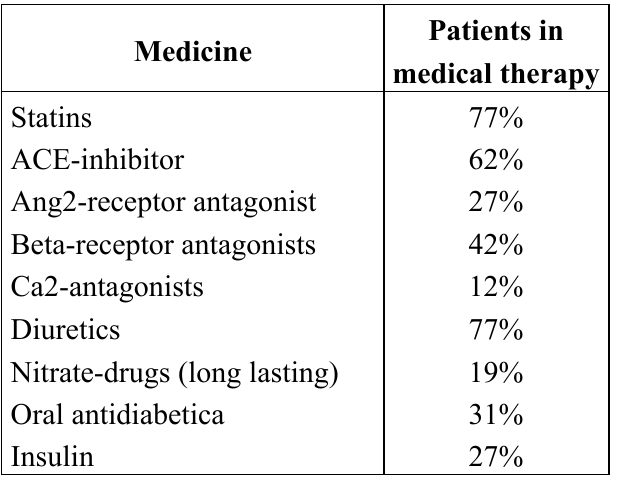
Table 3. Medical treatments of patients with HF and